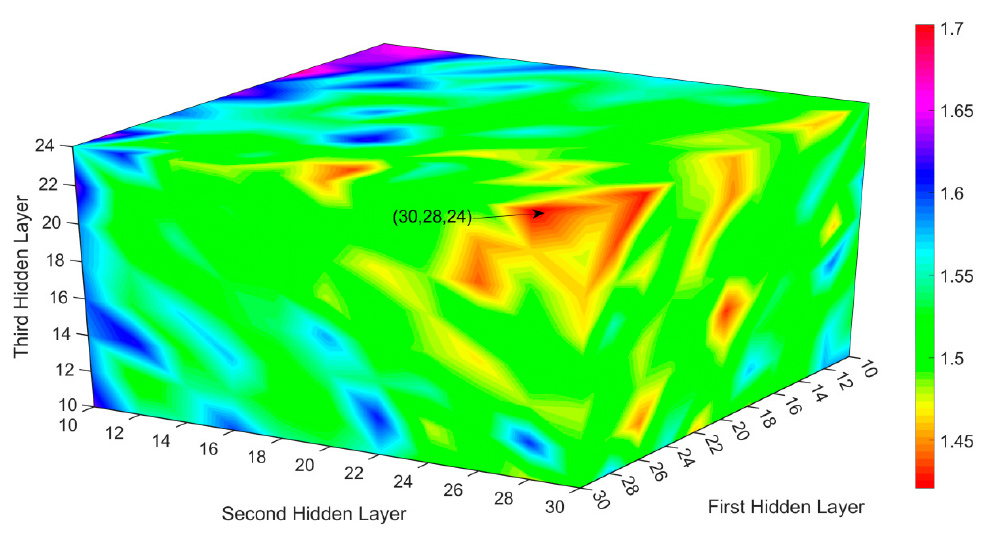
Figure 3. Statistical RMSEs of the JIM model with different neurons in three hidden